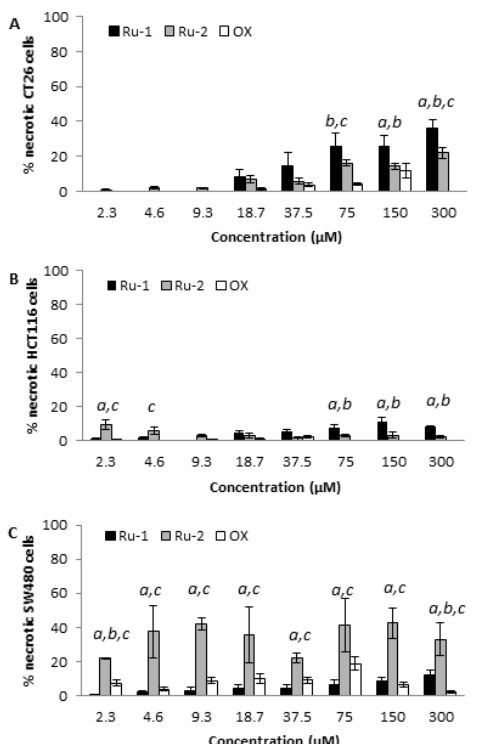
Figure 5. Cytotoxicity of ruthenium(II) terpyridine complexes against human and murine colon carcinoma cells. Effect of ruthenium(II) complexes and oxaliplatin on viability of ( A ) CT26 cells; ( B ) HCT116 cells; ( C ) SW480 cells after 24 h analyzed by LDH assay. All data are presented as mean values ± SD from three independent experiments performed in triplicates. p < 0.05, a— Ru-1 vs. Ru-2 ; b— Ru-1 vs. Ox ; c— Ru-2 vs. Ox . Molecules 2020 , 25 , x FOR PEER REVIEW